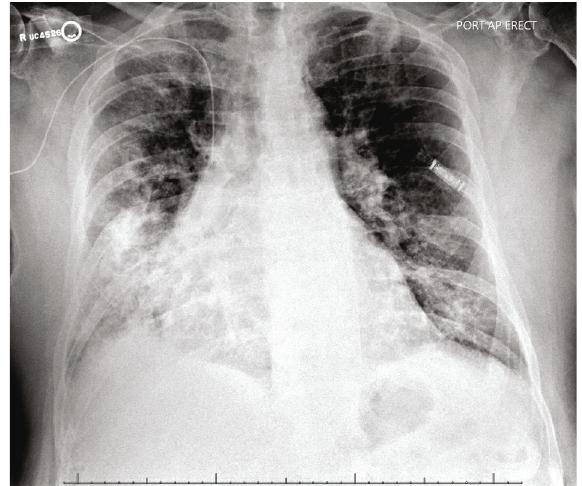
Figure 1: Anteroposterior erect chest radiograph at presentation. Frontal view of chest radiograph showing bilateral patchy in fi ltrates most pronounced in the right lower lobe concerning for multifocal pneumonia. Right PICC line and cardiac recorder device noted in the left anterior chest